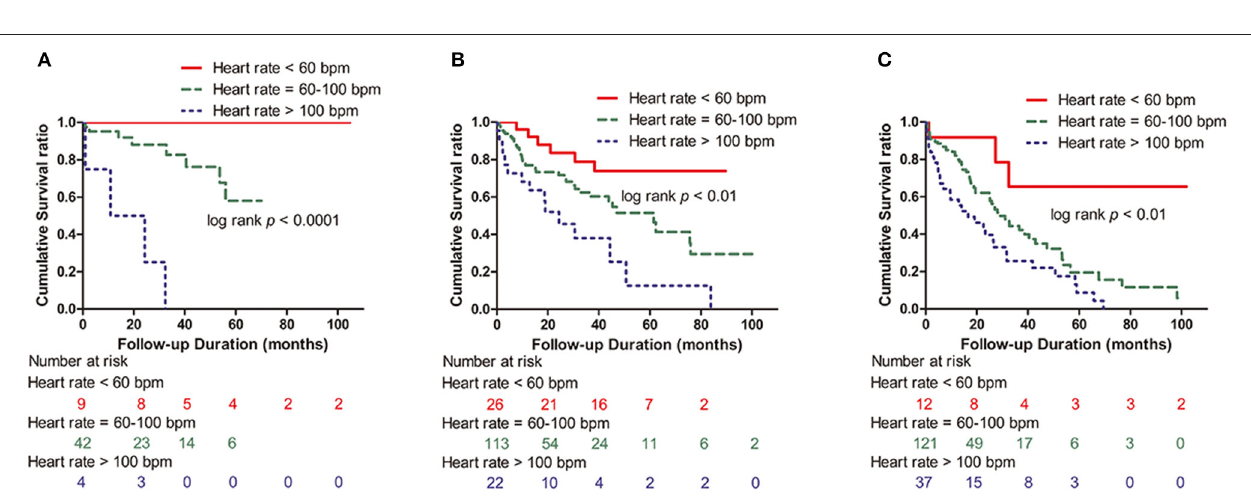
FIGURE 3 | Kaplan–Meier survival curves according to the presence of HR > 100 bpm, 60 ≤ HR ≤ 100 bpm, and HR < 60 bpm in the ISS groups. (A) Stage I group (log-rank p < 0.0001). (B) Stage II group (log-rank p < 0.01). (C) Stage III group (log-rank p < 0.01); ISS, International Staging System; HR, heart rate; bpm: beats per